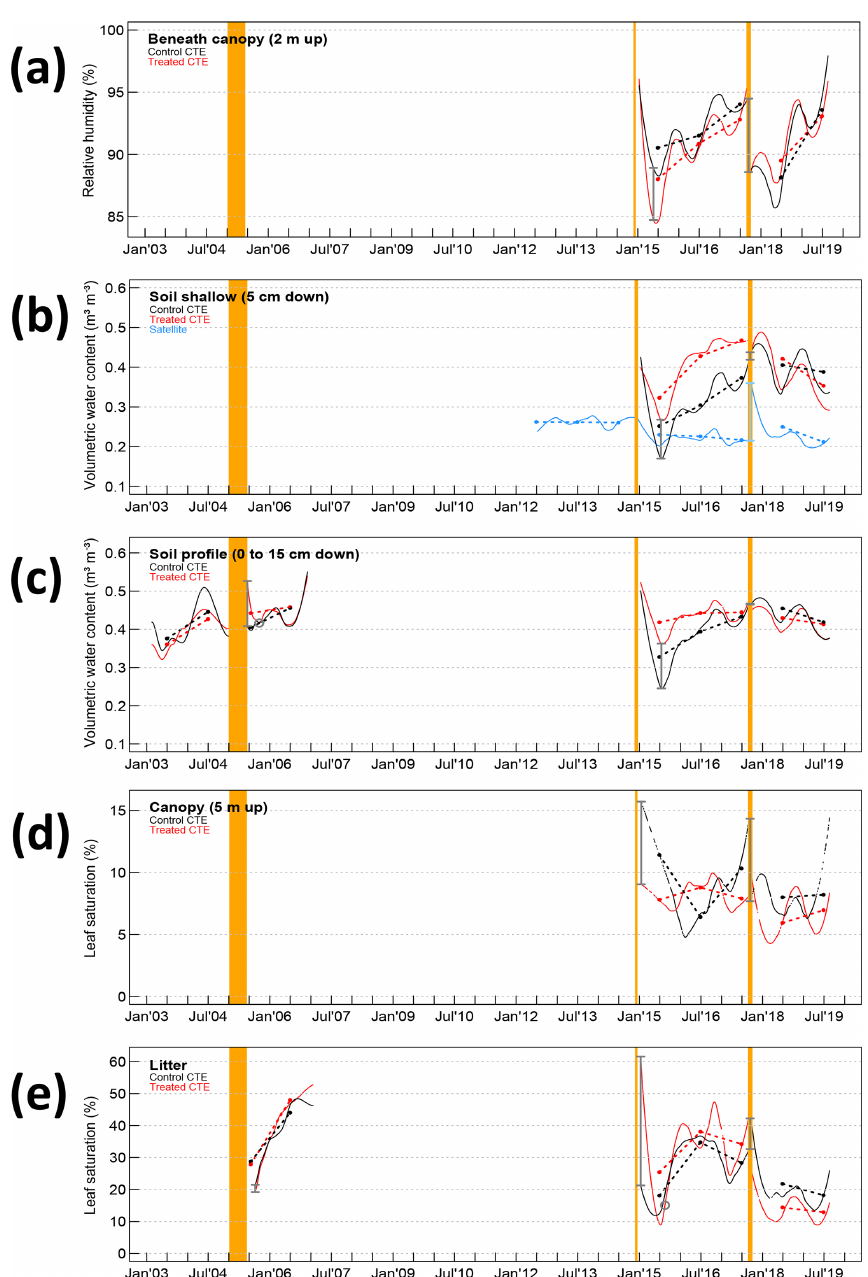
Figure 2. Secondary factor time series, or factors that change because of primary factor changes. All markings are the same as in Fig. 1. Plots show (a) air relative humidity, (b) soil moisture shallow, (c) soil moisture profile, (d) low canopy leaf saturation, and (e) litter leaf